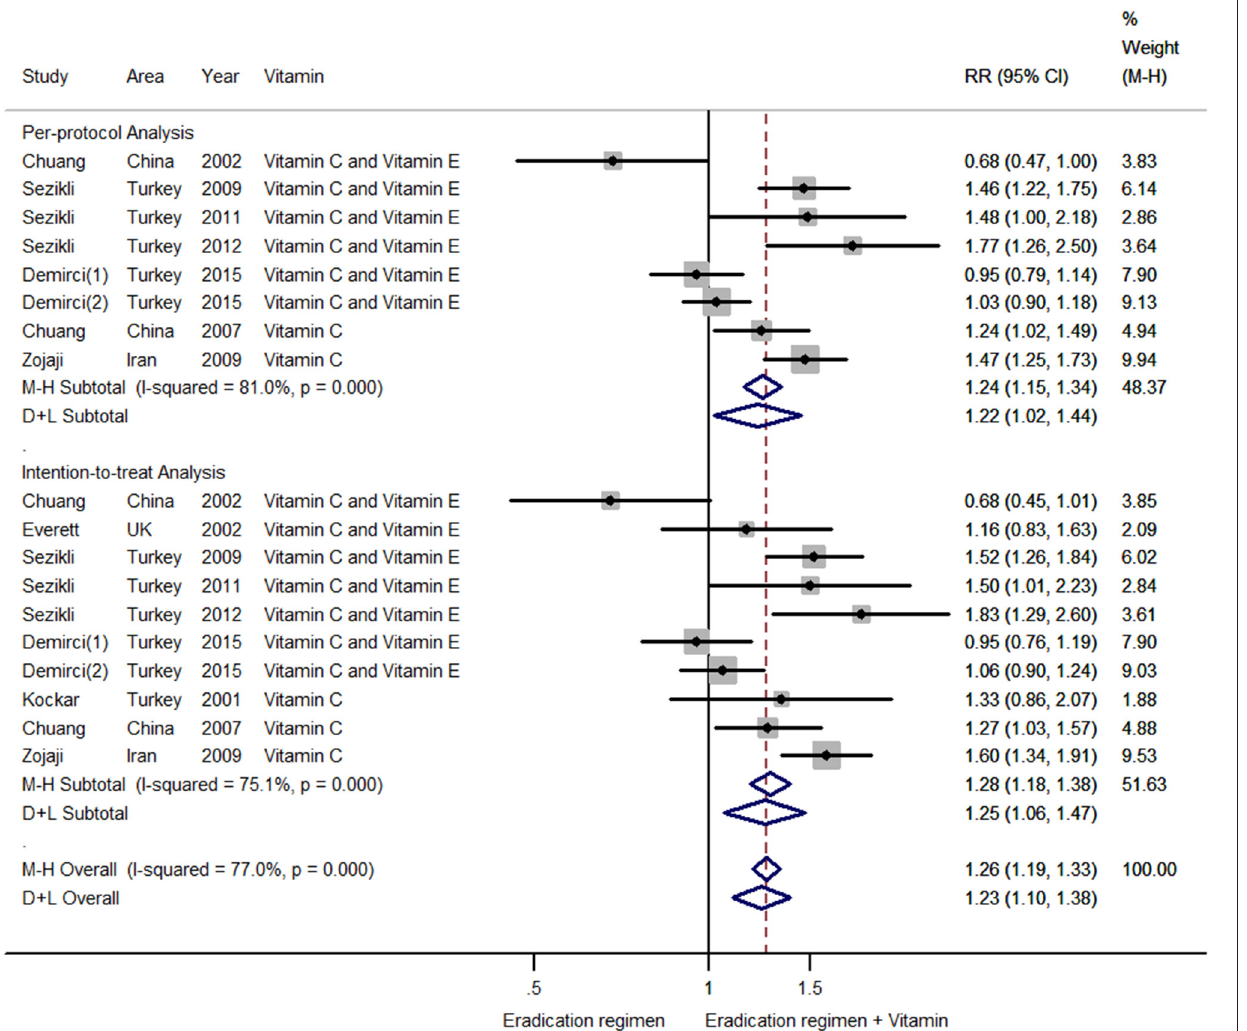
FIGURE 6 | Forest plot of the meta-analysis on the effects of vitamin supplements on H. pylori eradication rate (n1: number of eradication regimen plus vitamin supplement group; n2: number of eradication regimen group); For the per-protocol analysis, combining antioxidant vitamin supplementation with the standard therapy increased the H. pylori eradication rate (RR = 1.22; 95% CI: 1.02–1.44; P < 0.001; I 2 = 81.0%); For the intention-to-treat analysis, antioxidant vitamins supplementation increased the H. pylori eradication rate (RR = 1.25; 95%CI: 1.06–1.47; P < 0.001; I 2 =